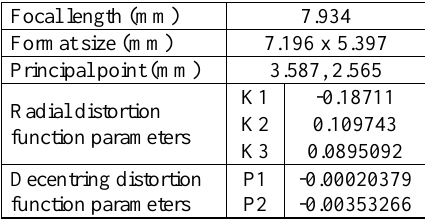
SfM algorithm lets to bundle block adjustment of collinearity